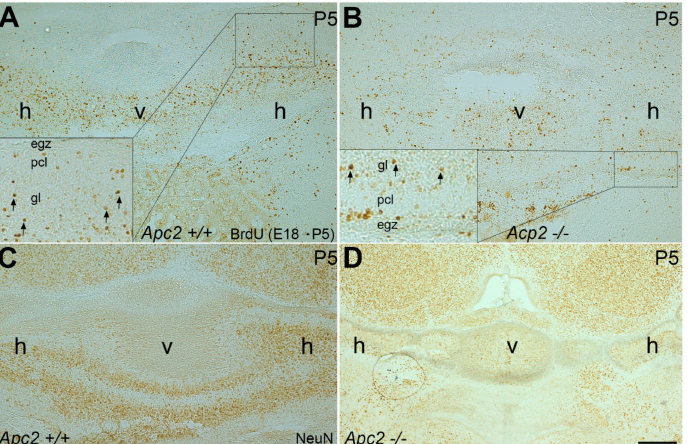
Figure 3. Visualization of BrdU incorporation in frontal sections at P5, following BrdU injection at E18 in timed pregnant mice. ( A , B ) BrdU staining shows that immunopositive cells migrate from EGZ to the GC layer (gl) in the wt ( A ) and nax ( B ) cerebellum, which is indicated by arrows in the inset. ( C , D ) NeuN immunostaining of serial sections of wt ( C ) and nax ( D ) cerebella confirming migration of mature GCs to the gl. Abbreviations: egz, external germinal zone; gl, granule cell layer; h, hemisphere; pcl, Purkinje cell layer; v, vemis. Scale bars: 200 µ m in ( D ) applies to ( A – D